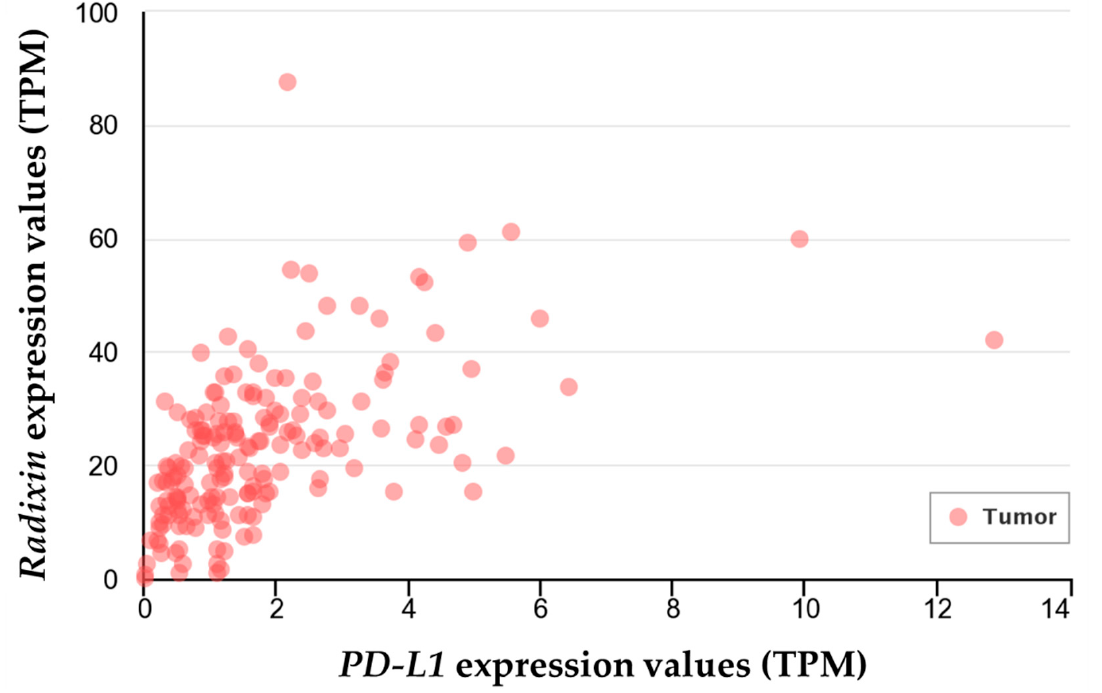
Figure 6. Gene-correlation analysis between programmed death ligand-1 (PD-L1) and radixin in human pancreatic ductal adenocarcinoma tissues. Correlation analysis for the gene expression of PD-L1 and radixin was performed in the clinical pancreatic ductal adenocarcinoma samples ( n = 178) from The Cancer Genome Atlas (TGCA) database using the publicly available online tool UALCAN. The estimated gene expression values based on RNA-seq data are presented as transcripts per million